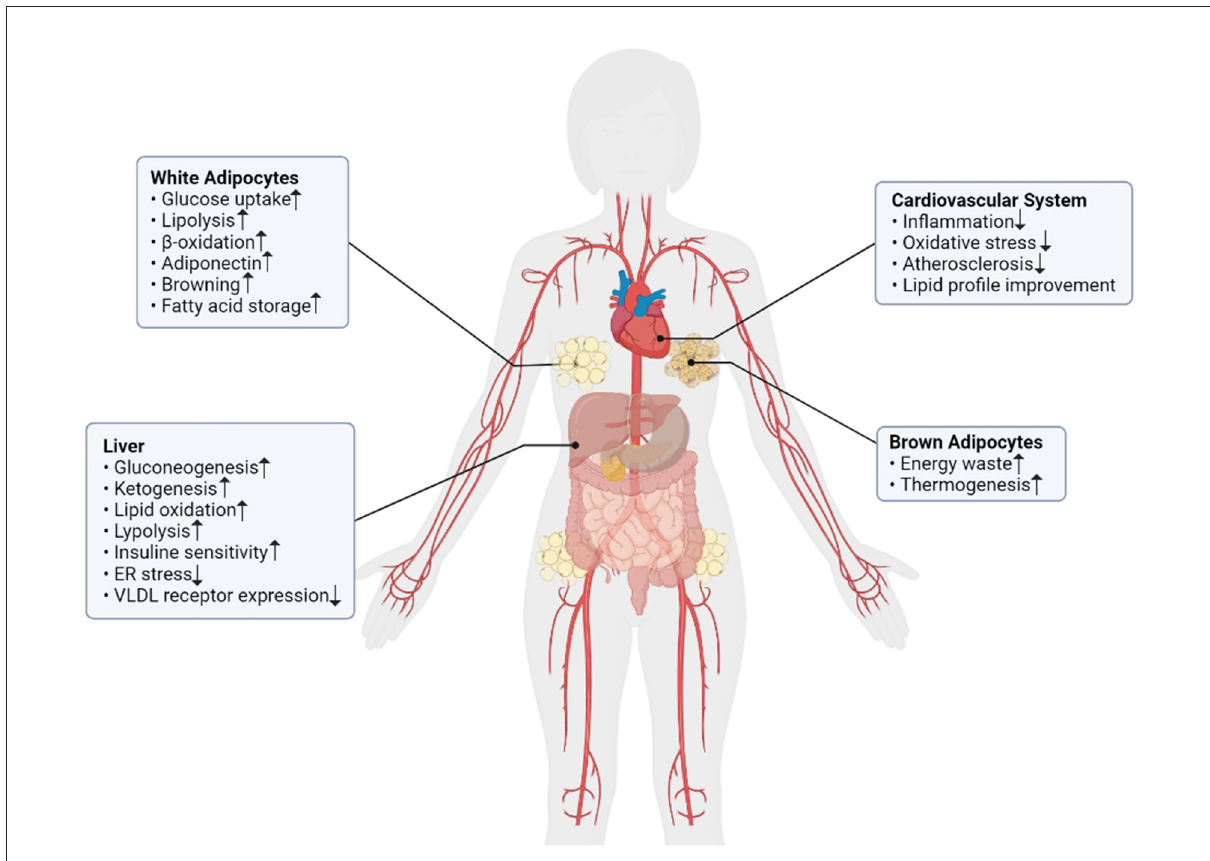
FIGURE1 The summarized effects of FGF21 in different metabolic pathways of